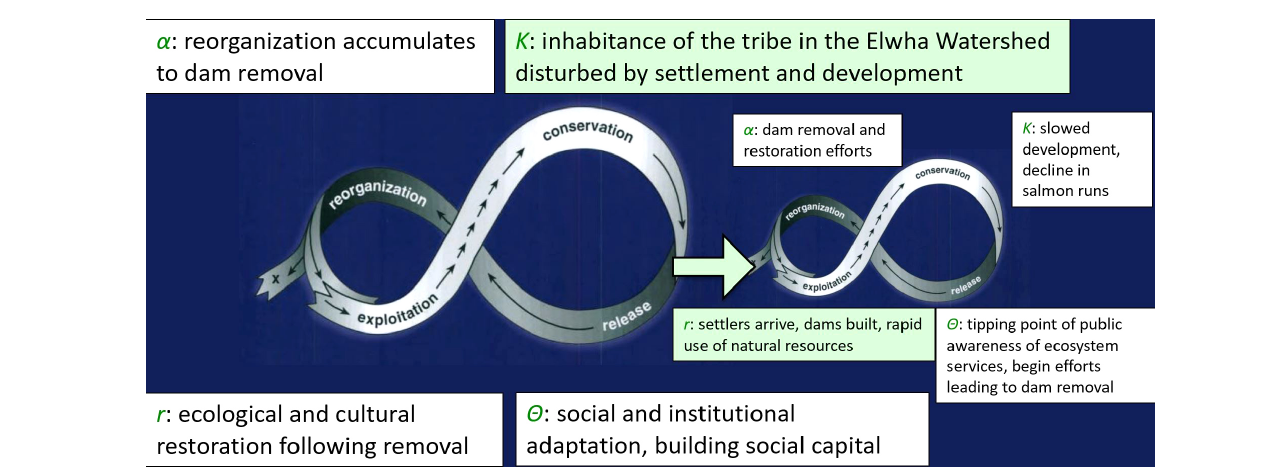
Fig. 3 . The adaptive cycle of the